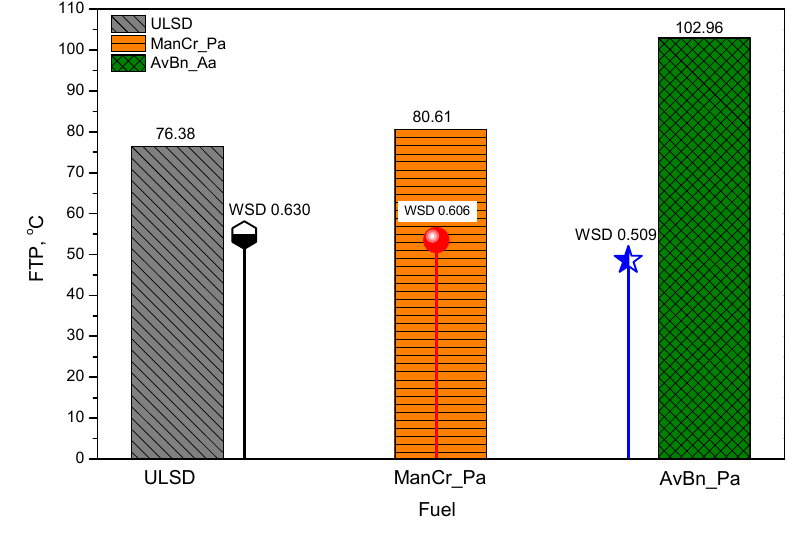
Figure 8. Correlation of FTP and WSD of the tested fuels.